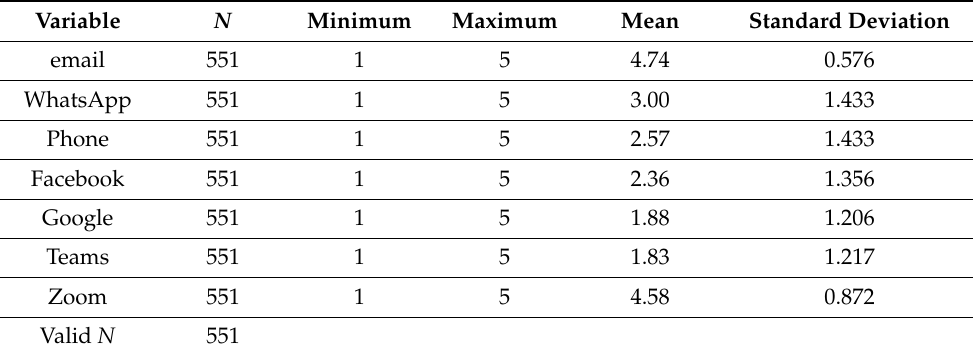
Table 22. Descriptive statistics of the communication method used for online